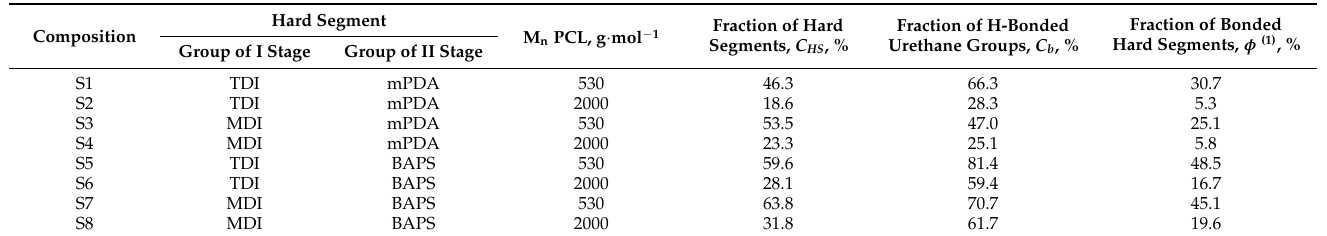
Table 1. Results of calculating the fraction of H-bonded urethane groups in multiblock